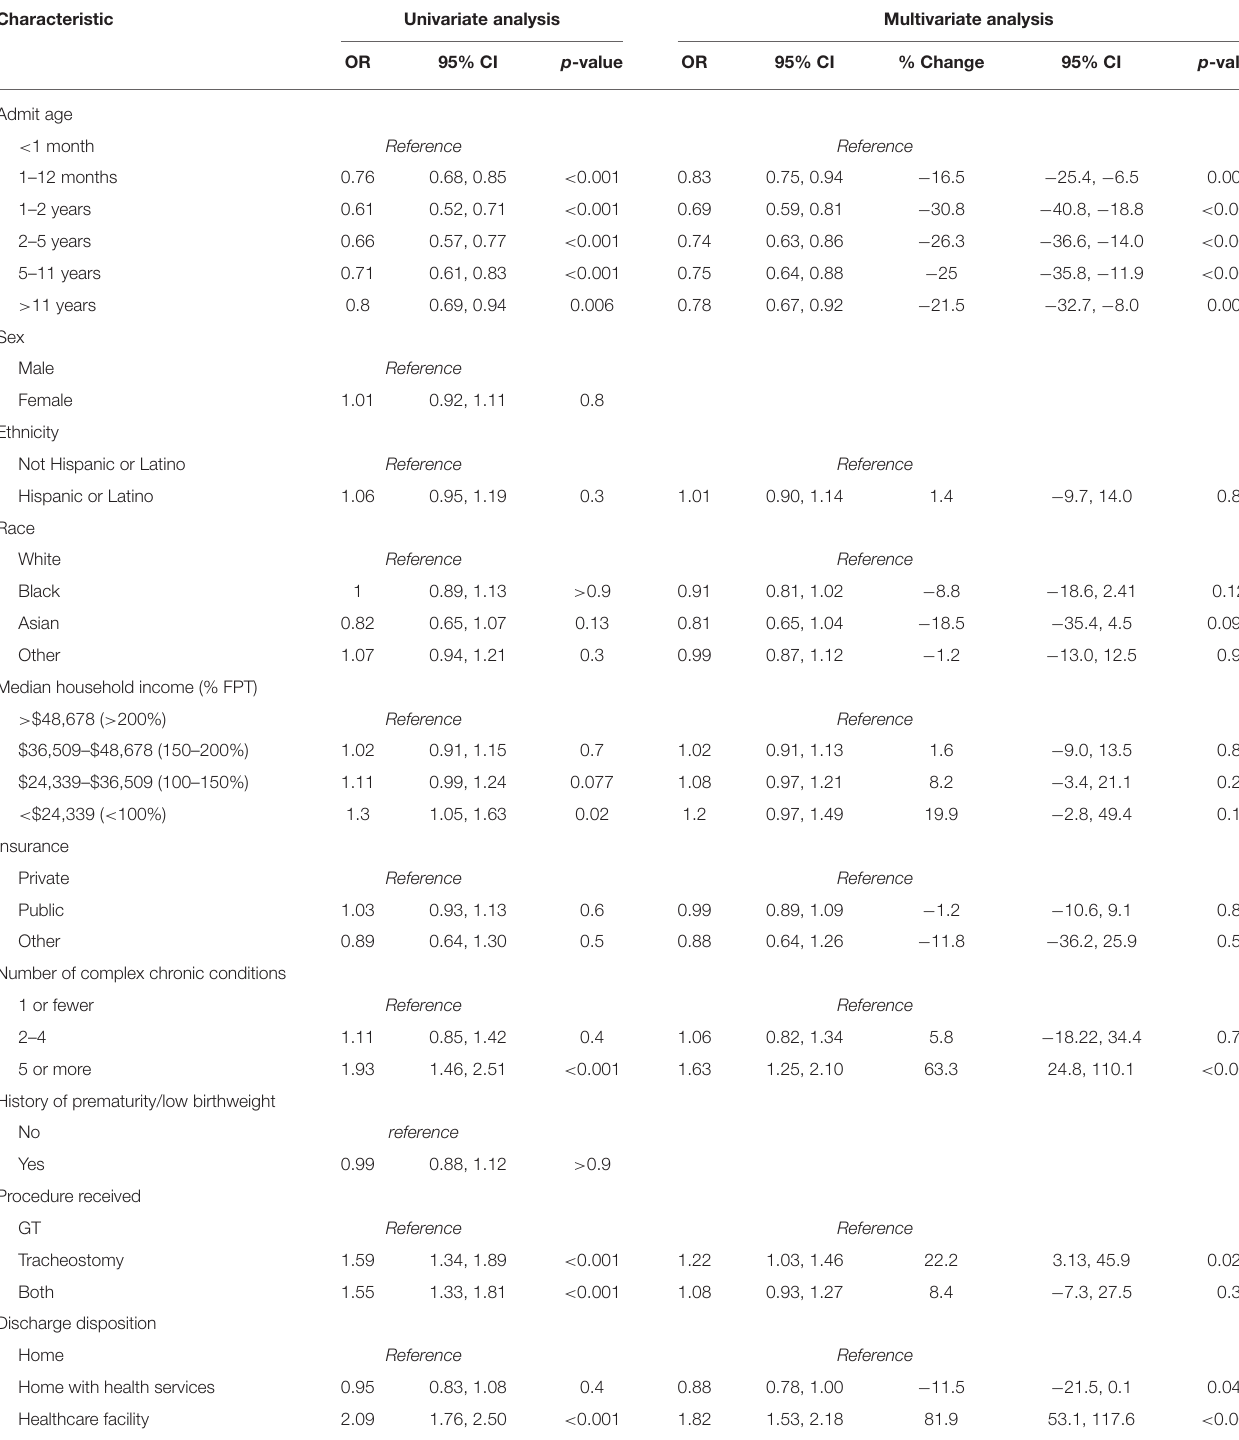
TABLE 4 | Univariate and multivariate analysis of characteristics predictive of total hospital costs 1 year after tracheostomy/GT placement.